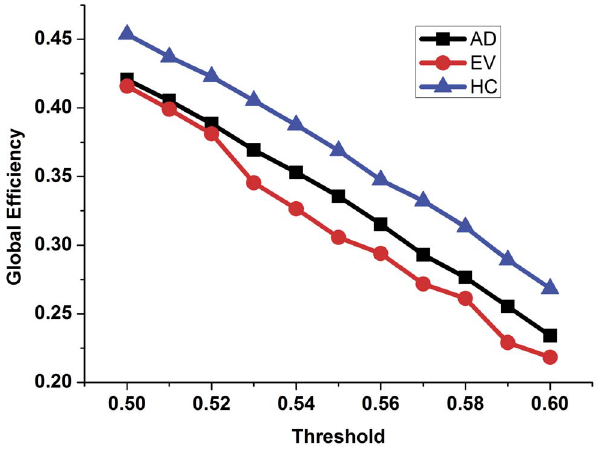
Figure 4. The global efficiency of the functional brain network of the healthy controls, AD patients and evolution under different thresholds. Blue triangles represent the healthy control group, black rectangles represent the group of patients with AD while the red dots represent the evolution network group.